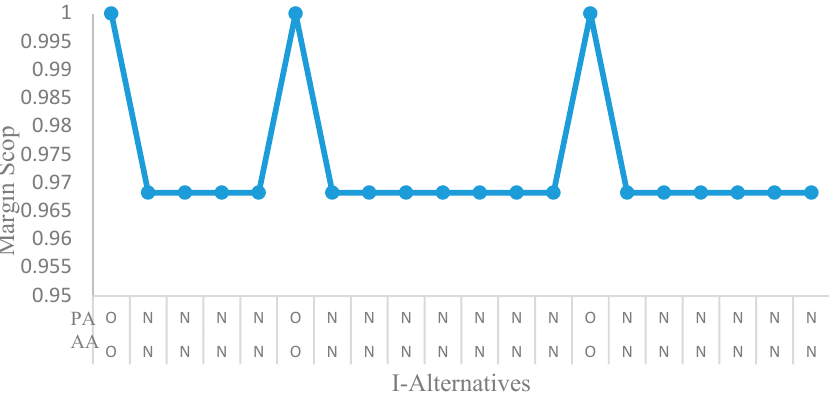
Figure 7. Prediction margin of optimal alternatives. AA: actual alternative; PA: predicted alternative.